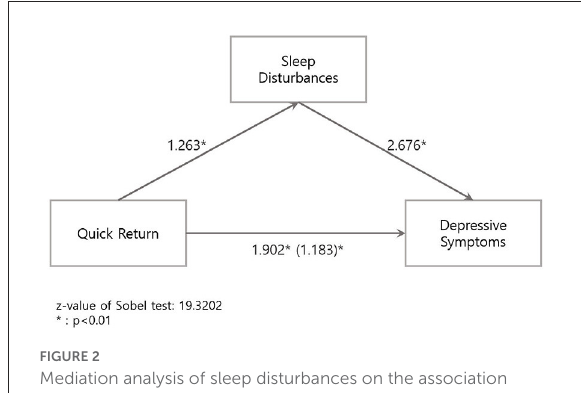
FIGURE2 Mediation analysis of sleep disturbances on the association between quick return and depressive